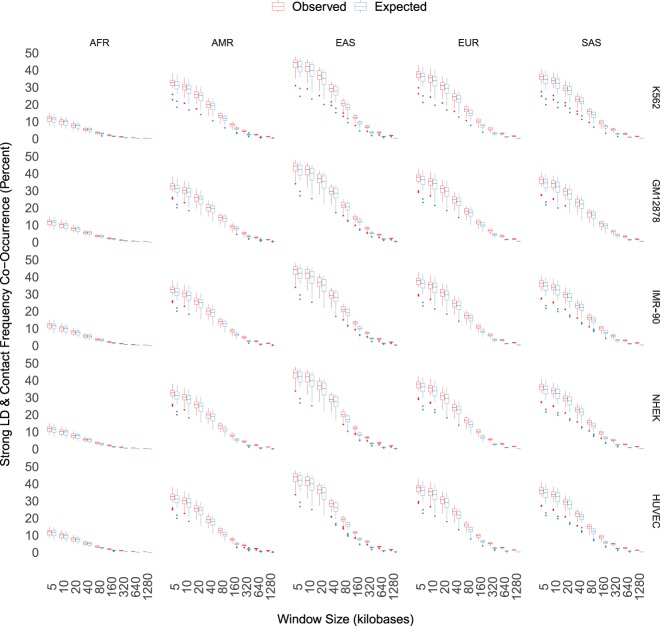
Frequent Hi-C contacts (top 25%) and strong LD (R2 > 0.8) co-occur <50% of the time at short genomic distances. Concordance is cut nearly in half at 40 kb, where most LD has decayed to 0, and is nearly 0 at many scales where statistically significant chromatin interactions occur. Maximum concordance and rate of decay vary by super-population, with AFR having only ∼12% concordance at short genomic distances. LD is elevated compared to expectation at the longest genomic distances, although the effect size is small and median LD is close to zero.